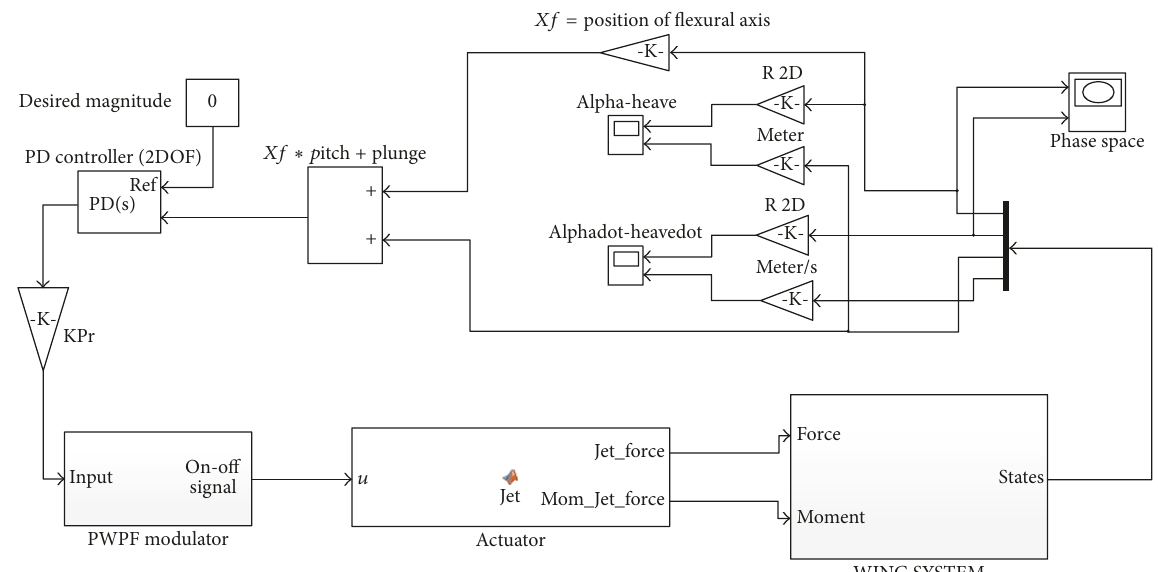
Figure 7: MATLAB block diagram of a two-dimensional wing controller with the modulator.